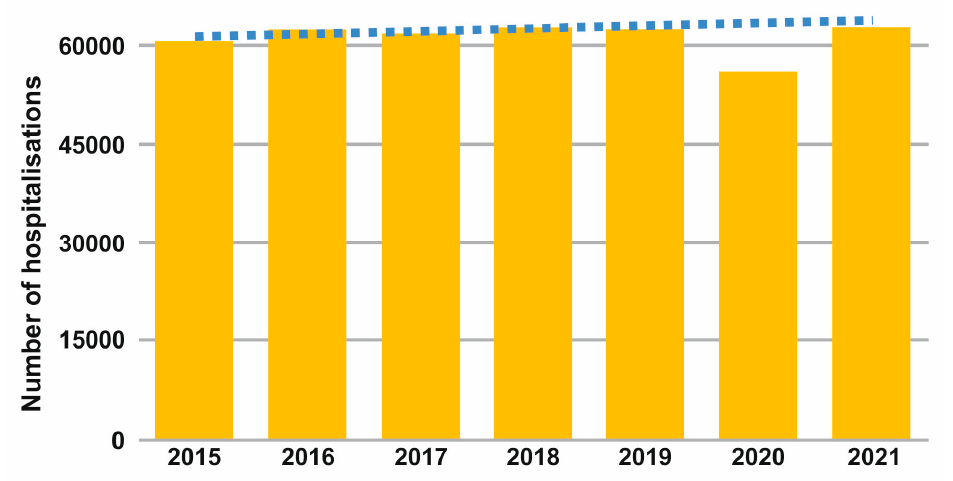
Figure 1. Number of hospitalisations for breast cancer in the period